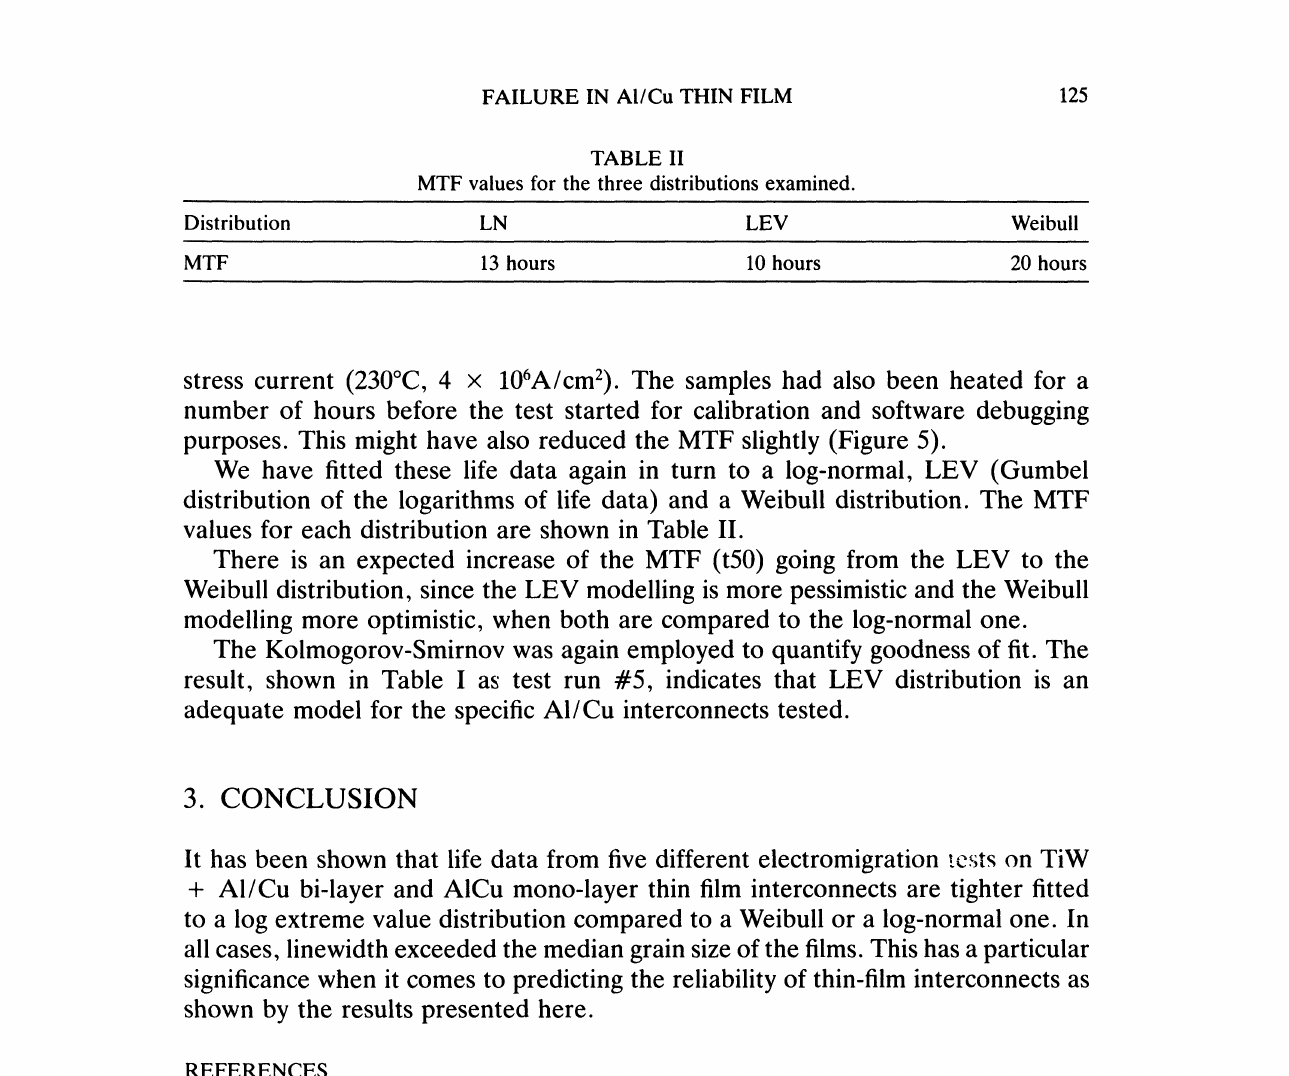
TABLE II MTF values for the three distributions